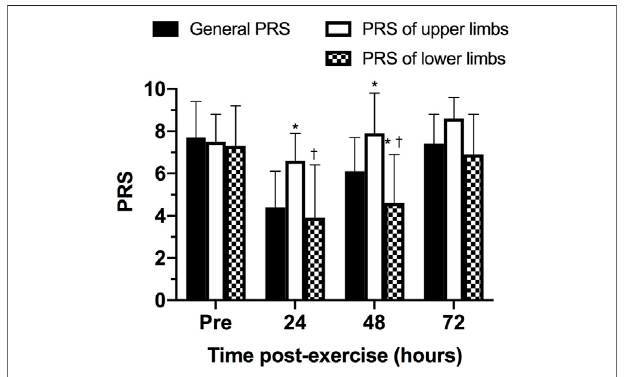
FIGURE 6 | Comparison between scores of general, lower and upper limbs of perceived recovery scale (PRS) at different time points. * p ≤ 0.05 for general PRS; † p ≤ 0.05 for PRS of upper